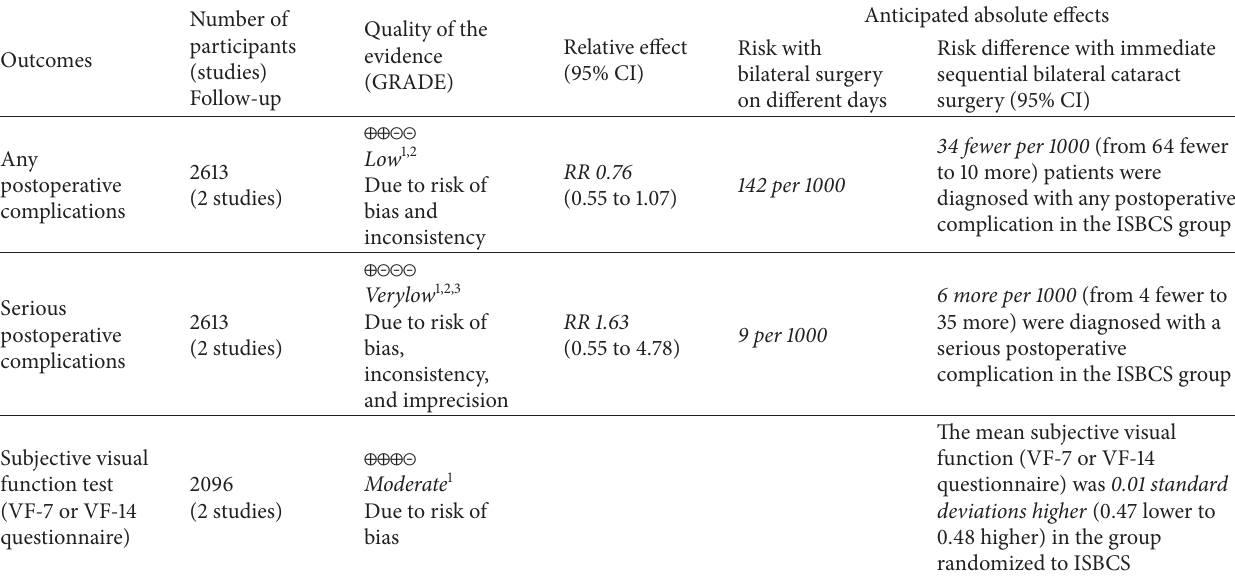
Table 4: Quality assessment and summary of findings.